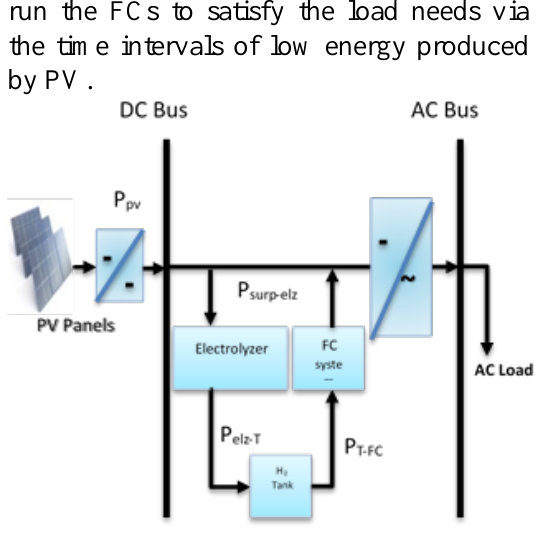
Fig. 1: The proposed PV/FC design for the studied